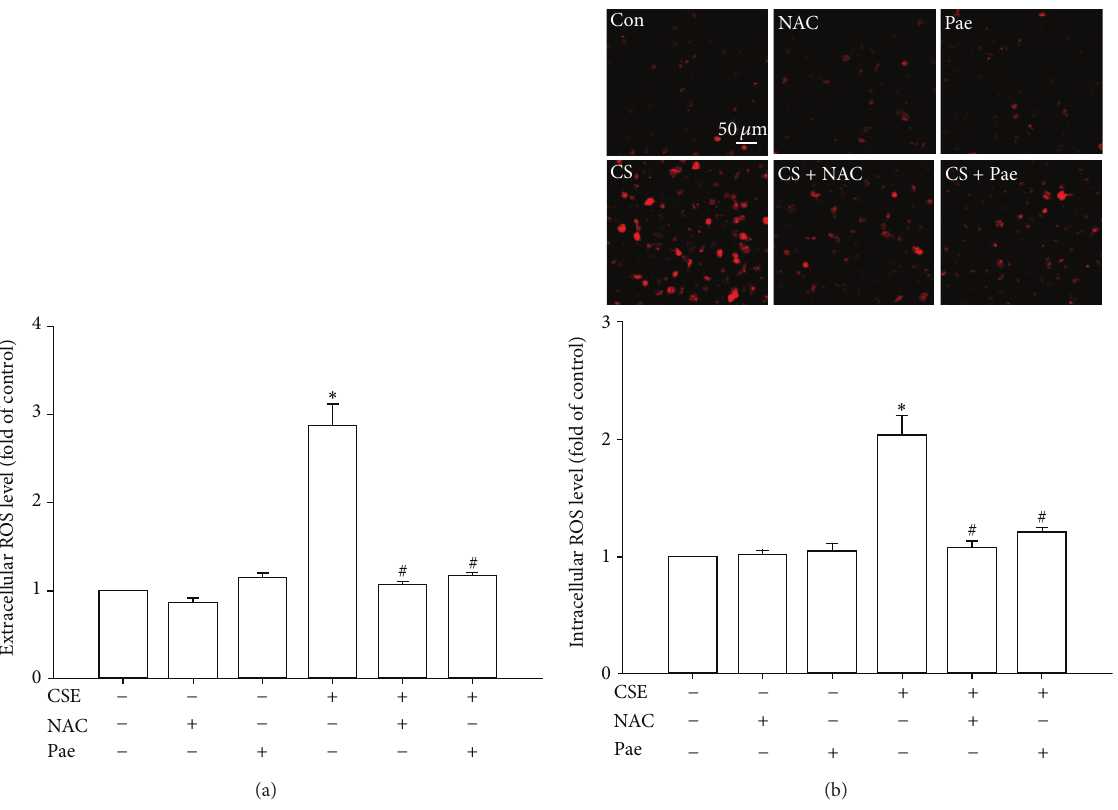
Figure 6: Paeonol (Pae) attenuates increases in extracellular and intracellular levels of reactive oxygen species (ROS) induced by cigarette smoke extract (CSE) in human bronchial epithelial cells. Cells were exposed to medium alone or 3% CSE for 2 (a) and 30 minutes (b) with pretreatment with N-acetyl-cysteine (NAC, 2 mM; a ROS scavenger), Pae (0.4mM), or the vehicle of Pae. After exposure, the culture medium was removed for the measurement of extracellular ROS levels (a). The cells were collected for the measurement of intracellular ROS levels (b). Levels of ROS were measured by HE/ETH fluorescent probe assay. Data in each group are mean ± SEM from four independent experiments. ∗ 𝑃 < 0.05 versus control. # 𝑃 < 0.05 versus CSE without drug